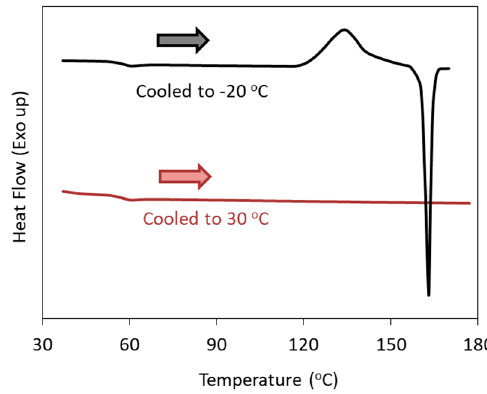
Figure 5. Reheating DSC curves of celecoxib melt, illustrating the dependence of the cold crystallization on the target temperature of the cooling process (shown in the figure).